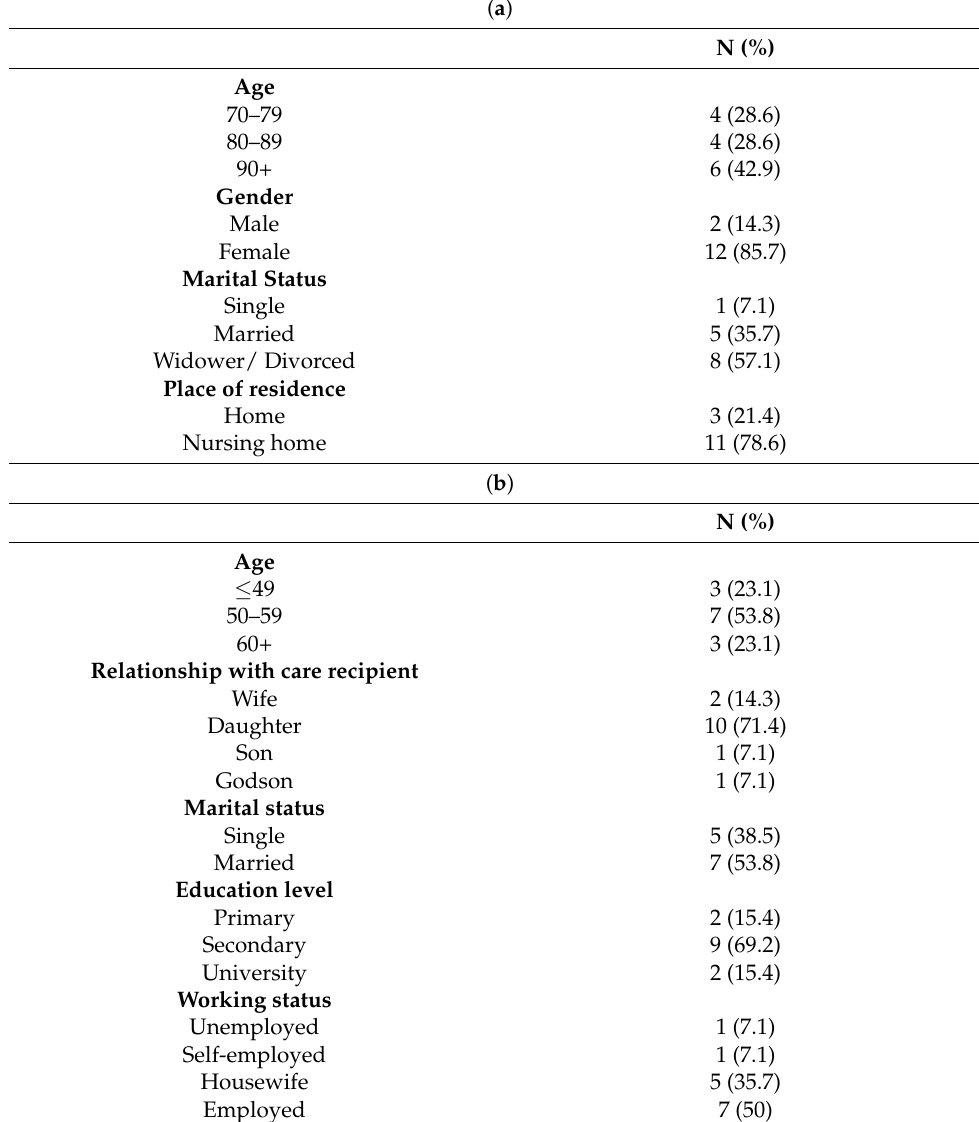
Table 1. ( a ). Demographics of included patients ( n = 14 *). ( b ). Demographics of caregivers ( n = 14